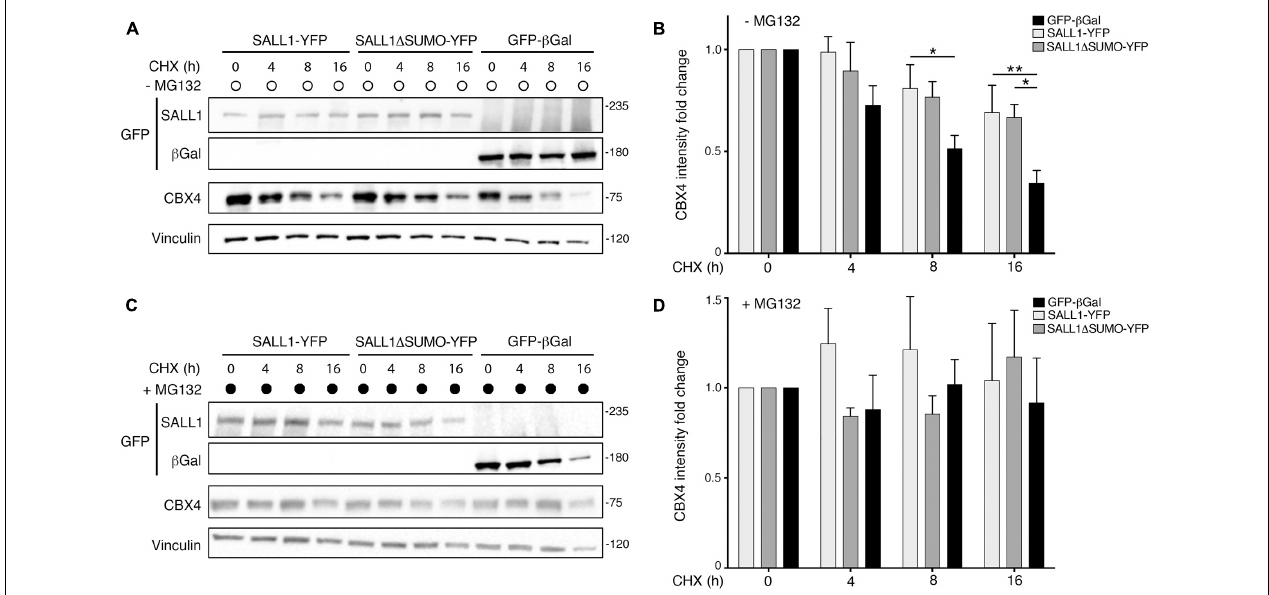
FIGURE 5 | SALL1 stabilizes CBX4 protein. (A,C) Western blot analysis of cycloheximide (CHX) chase experiments performed in HEK 293FT cells transfected with SALL1-YFP , SALL1 (cid:49) SUMO-YFP , or GFP- β -gal . Cells were treated with 50 µ g/ml of CHX in the absence (A) or presence (C) of 10 µ M of the proteasome inhibitor MG132. Cells were collected at different time points (0, 4, 8, and 16 h after initiation of treatment) and endogenous CBX4 levels were analyzed by Western blot. Vinculin was used as loading control. Molecular weight markers are shown to the right in KDa. Antibodies were used as indicated to the left. (B,D) CBX4 levels were quantified after CHX treatment alone (B) or in combination with MG132 (D) , normalized to Vinculin, and data from six different independent experiments were pooled together. Graphs show mean plus SEM. P -values were calculated using one-way ANOVA test. * P -value < 0.05; ** P -value < 0.01.